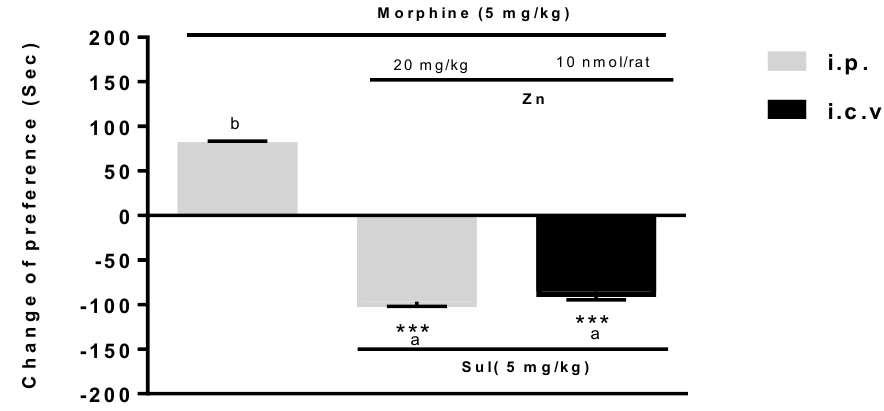
Figure 5. Figure 5. Effect of sulpiride on the enhancement effect of Zn on the expression of morphine-induced CPP. Zn was given i.p. (20 mg/kg) and i.c.v. (10 nmol/rat) separately after the sulpiride treatment in the post-conditioning sections. Each point represents the mean± SEM of six Figure 5. rats. *** Presents significant between saline (10 ml/kg, i.p.) group at P < 0.001. Different letters indicate significant differences between groups (p<0.05) (Tukey’s post-hoc test). Zn=Zinc, and Sul= sulpiride. mean± SEM of six rats. *** Presents significant between saline (10ml/kg, i.p.) group at P